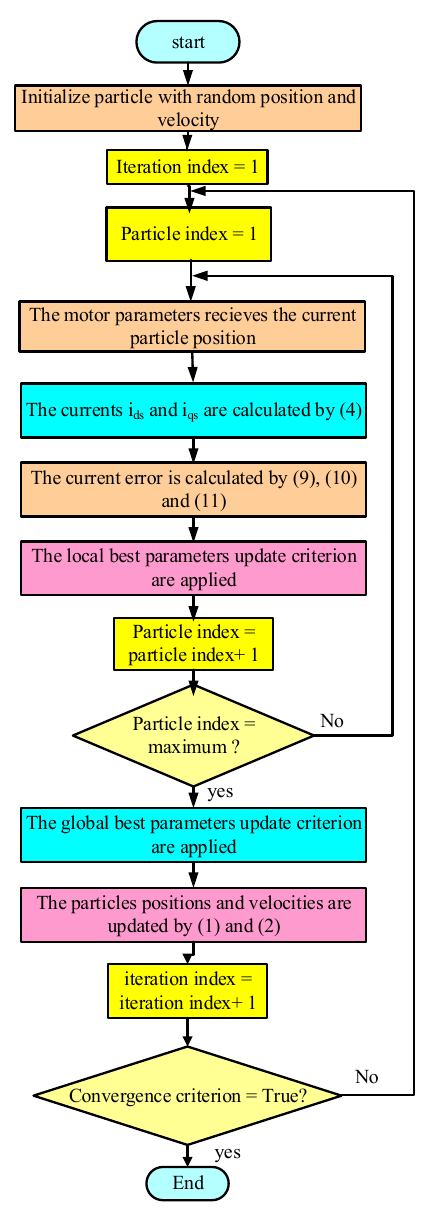
Figure 3. Flowchart of PSO algorithm.